Question: In one sentence, what is this figure communicating?
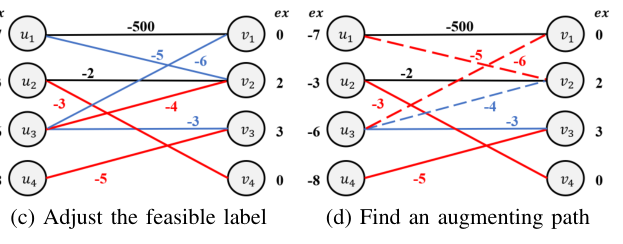
Answer: An illustrate of the KM-M algorithm.